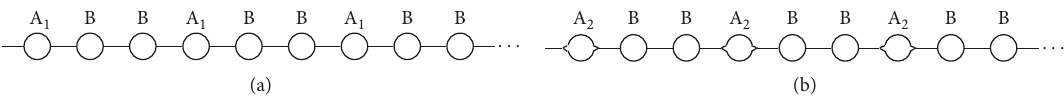
Figure 3: Blast hole layout diagram. (a) The PBH is a round hole. (b) The PBH is a notch hole.